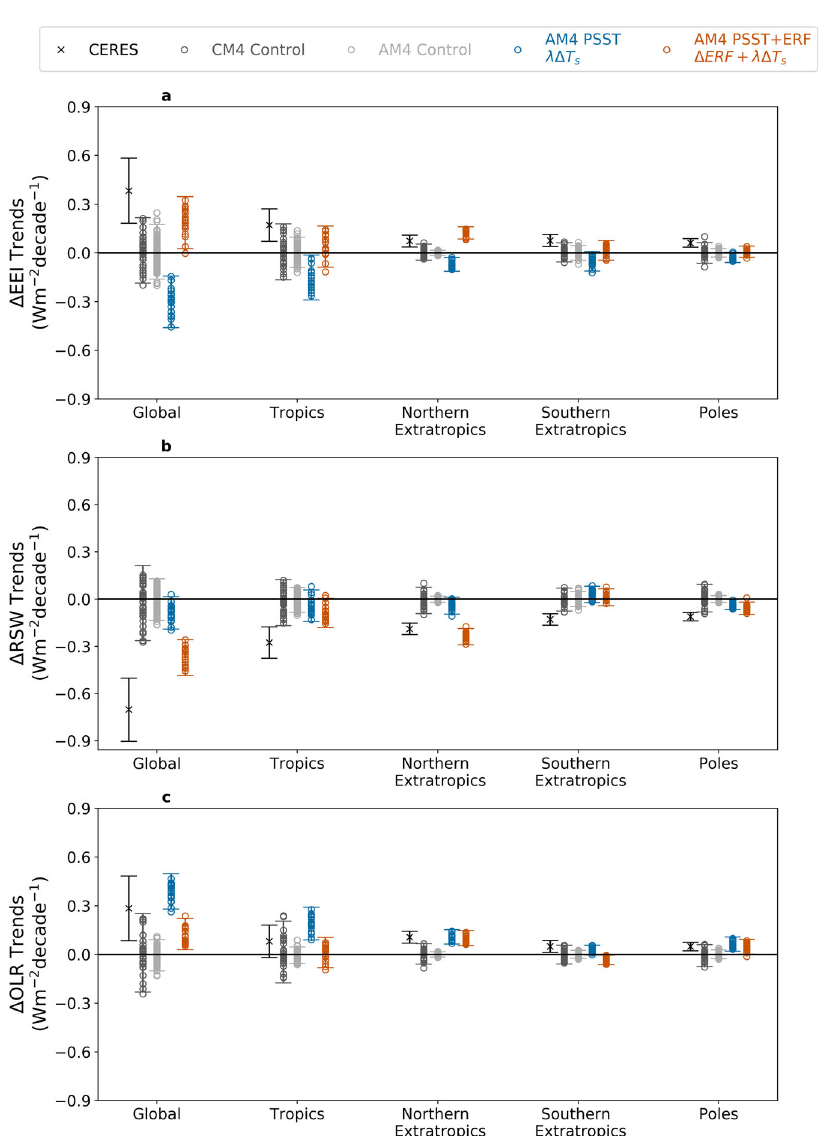
Fig. 3 Regional radiative trends in Clouds and the Earth ’ s Radiant Energy System (CERES) observations and a hierarchy of Geophysical Fluid Dynamics Laboratory (GFDL) climate model experiments. a Earth ’ s energy imbalance (EEI). b , Same as a , but for re fl ected shortwave radiation (RSW). c Same as a , but for outgoing longwave radiation (OLR). Positive EEI indicates more energy in the system while positive RSW and OLR indicate less energy. Values are relative to the global mean, i.e., area-weighted. Tropics (30°S – 30°N), northern extra-tropics (30°N-60°N), southern extra-tropics (30°S – 60°S), and poles (60°S – 90°S and 60°N – 90°N). ±2 σ range marked by dashes. For models, this is the range of radiative trends due to internal variability ( ϵ ). For the observations, this is the range due to observational uncertainty. See Supplementary Fig. 1 for the equivalent fi gures but with 95% con fi dence intervals as uncertainty estimates and text for details. CERES ’ s global trend in Δ EEI exceeds control experiments ’ ϵ (see text for details and Fig. 2) and only lies in the realm of the experiment with prescribed SST and sea ice (observed) and effective radiative forcing (AM4 PSST + ERF). See Eq. 1 and text for details on λ Δ T s (blue) and λ Δ T s + Δ ERF(orange) ( Δ represents anomalies). CM4 = GFDL Coupled Model 4 (CM4 Control given by dark gray) and AM4 = GFDL Atmosphere Model 4 (AM4 Control given by light